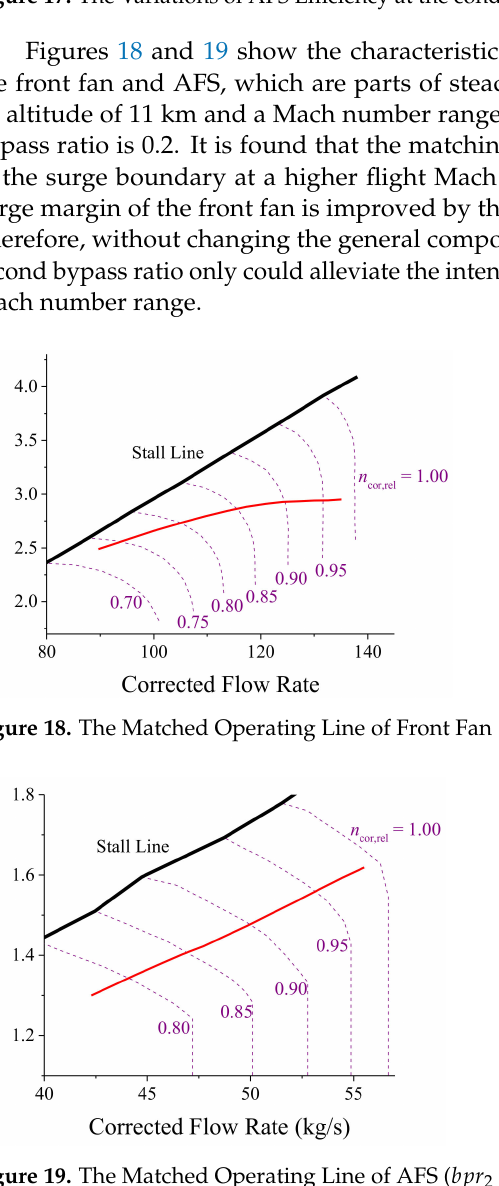
Figure 17. The Variations of AFS Efficiency at the conditions of Different Second Bypass Ratios ( bpr 2 ).